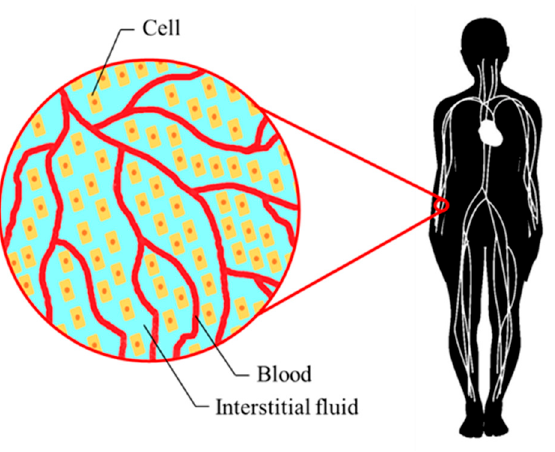
Figure 2. Analysis object viewing peripheral tissues as porous media. In the present study, mass transfer between extracellular and intracellular fluid phases is considered.